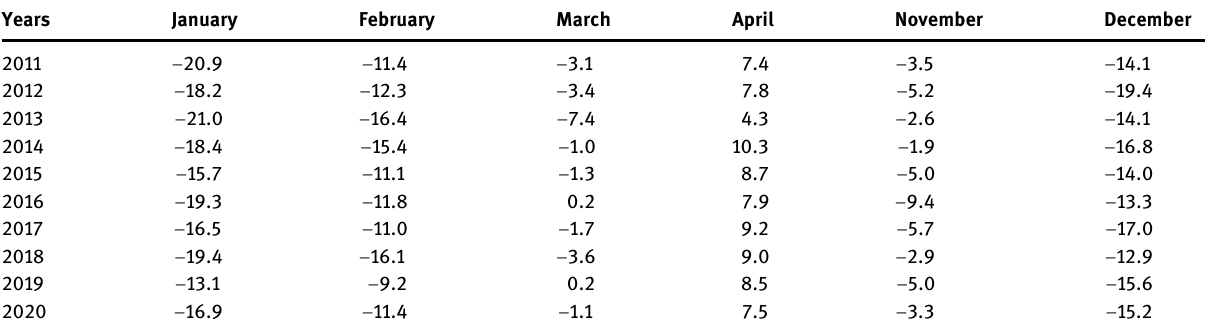
Table 1: Monthly average temperatures ( °C ) in Harbin in the winter for the period from 2011 to 2020